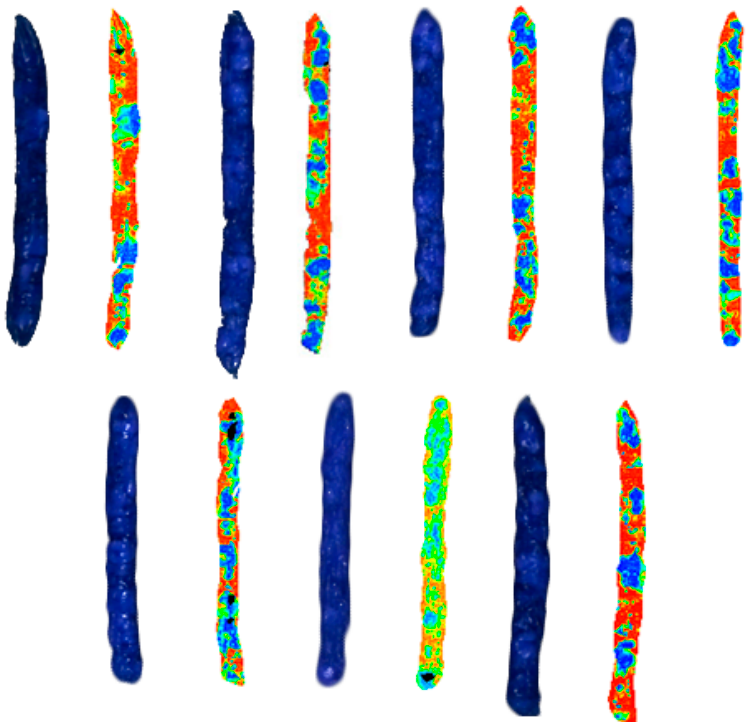
Figure 2. Seven groups of near infrared spectroscopy (NIR) hyperspectral images of sausage samples and the corresponding pseudo color images. The deeper the red, the higher the degree of lean meat membership.